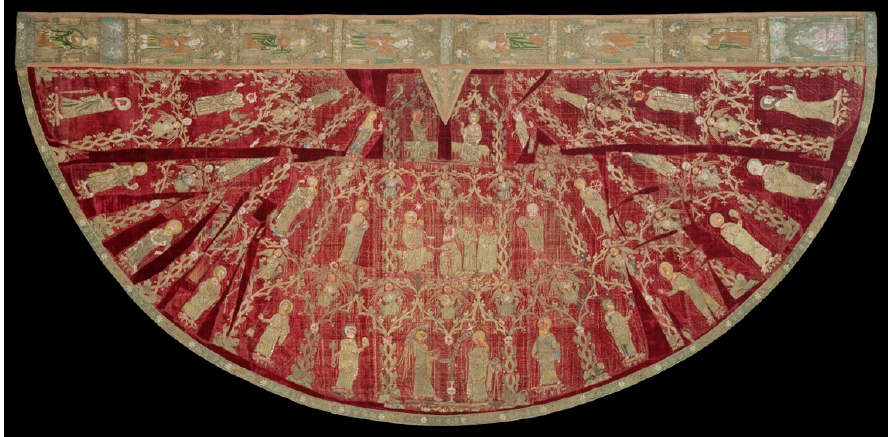
Figure 21. Butler-Bowdon Cope, ca. 1335–1345. London, Victoria and Albert Museum, England. © Victoria and Albert Museum, London.